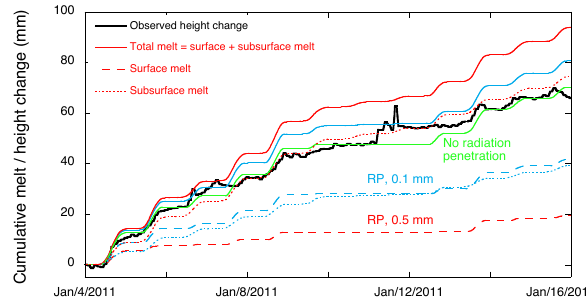
Fig. 8. Comparison between observed and modeled snow tem- perature at 0.5m depth at AWS 14, for different model settings of radiation penetration. Observed snow temperature (interpolated to 0.5m) shown in black; model without radiation penetration in green; model with radiation penetration (0.1mm snow grain radius) in blue; model with radiation penetration (0.5mm snow grain ra- dius) in red.